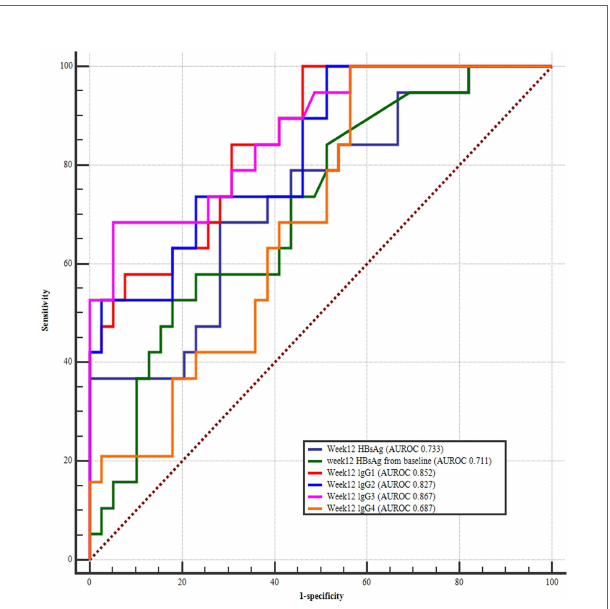
FIGURE 3 | ROC curves of baseline HBsAg, IgG1, IgG2, IgG3, and IgG4 levels for predicting HBsAg clearance. Baseline lgG2 had the largest area under the curve (AUROC 0.880), followed by the baseline lgG1 (AUROC 0.824), lgG3 (AUROC 0.771), HBsAg (AUROC 0.646), and lgG4 (AUROC 0.596) levels.